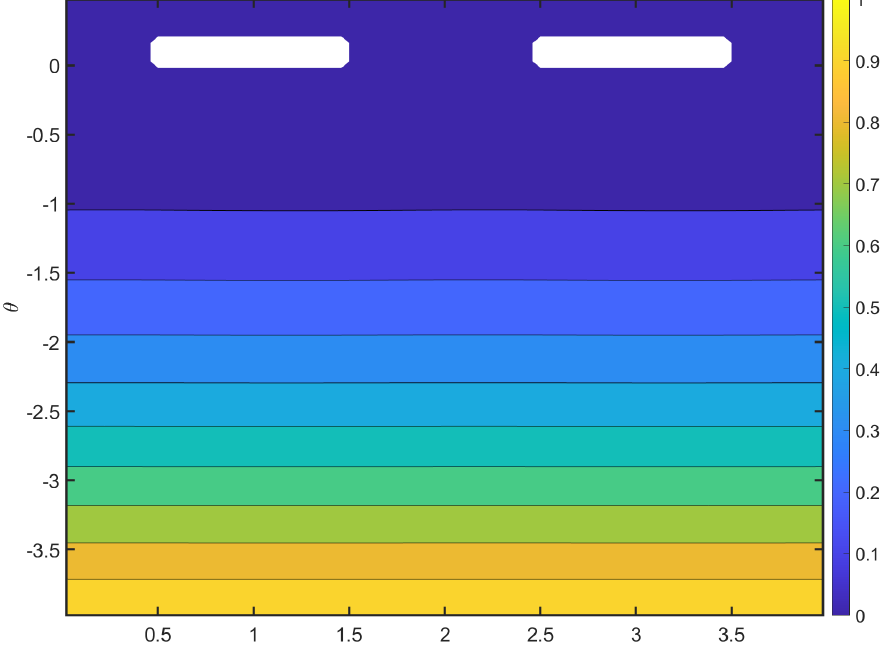
Figure 8. Temperature distribution in SAW with cooling at higher power while cooling from